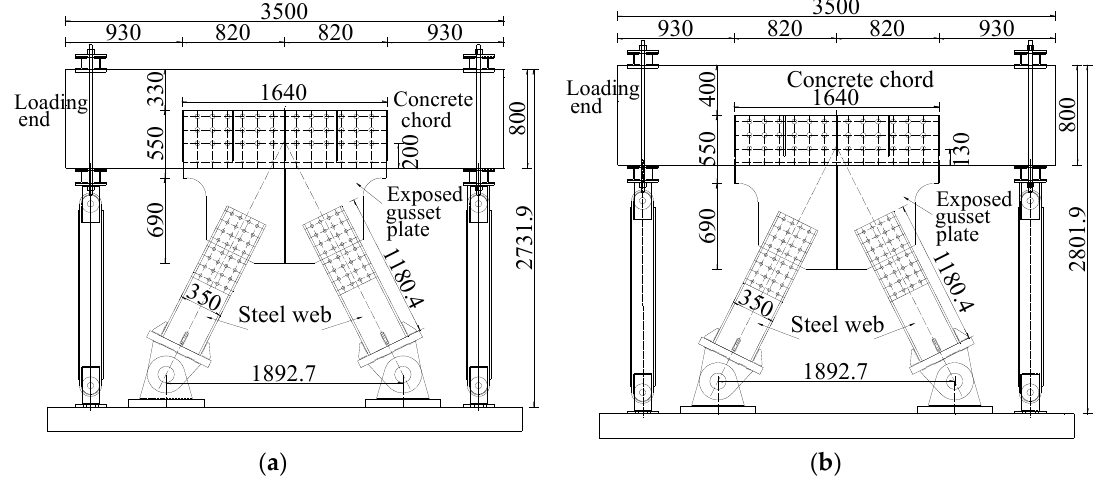
Figure 6. Details of composite joint specimens ( a ) CJA and ( b ) CJB.